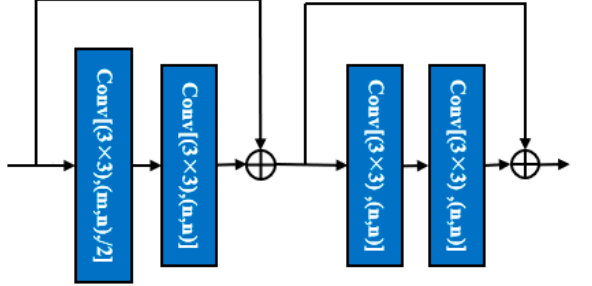
Figure 3. Structure diagram of the convolution module in the encoder.